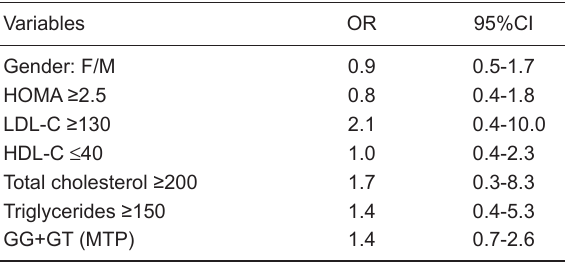
Table 6. Logistic regression analysis with steatosis as the de- pendent